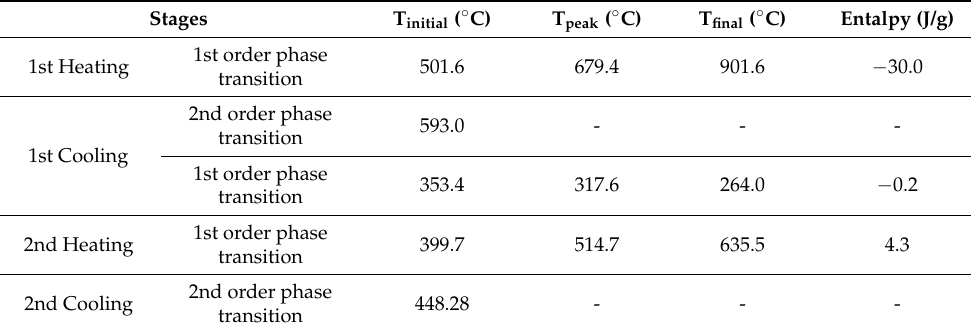
Table 4. Data were obtained from the DSC of the Ti 10 Mo 8 Nb 6 Zr